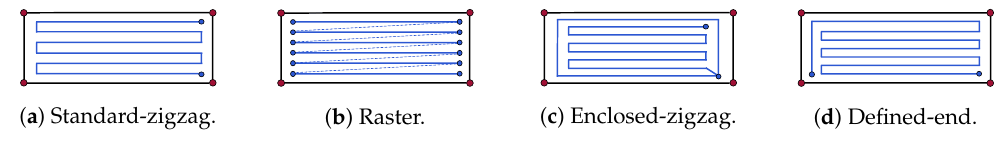
Figure 10. Analyzed infill strategies.